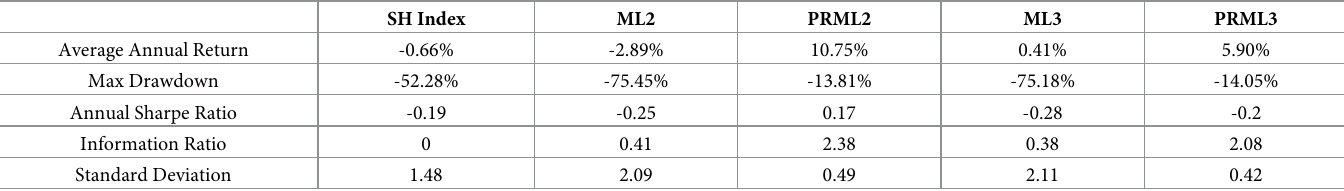
Table 3. Finance performance of forecasting one day ahead: PRML vs.